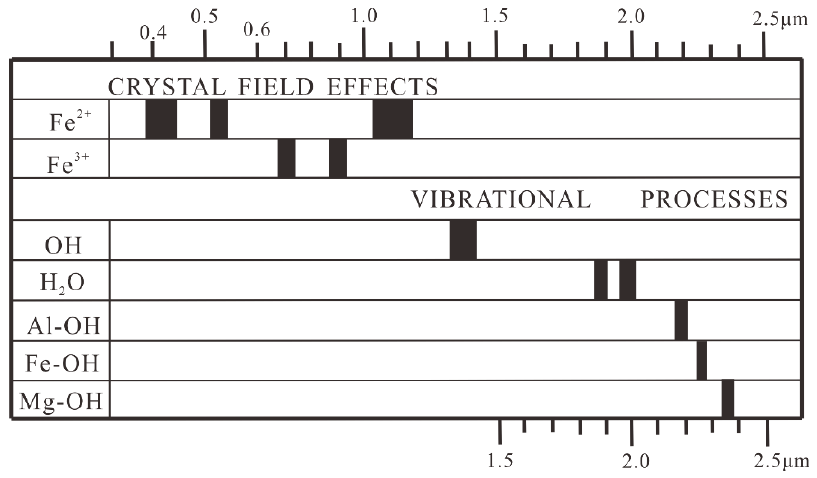
Figure 3. The spectral absorption features of chlorite [15,17,18].